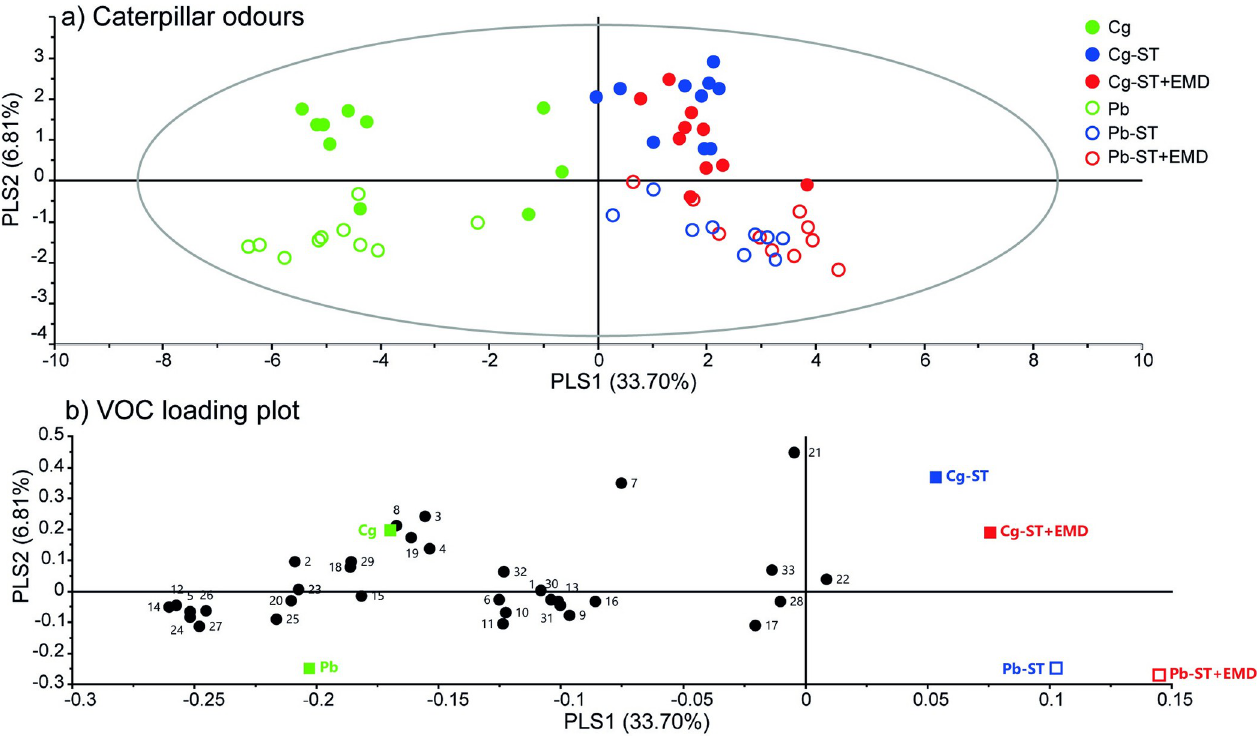
Fig 3. Overview of caterpillar volatile profiles of untreated, starved or starved then external microbiome disrupted C . glomerata parasitised or unparasitised caterpillars ( P . brassicae ). a) OPLS-DA (Orthogonal Projection to Latent Structures Discriminant Analysis) plot for the volatile blends of different groups of caterpillars. The Hotelling’s T2 ellipse confines the confidence region (95%) of the score plot. b) Loading plot defining the contribution of each of the volatile compounds to the separation of treatment groups. Volatile compounds closer to a treatment in the plot correlate stronger with the treatment. For compound identity see Table 1. Abbreviations used: Cg = Untreated parasitised caterpillars; Cg-ST = starved parasitised caterpillar; Cg-ST +EMD = starved then external microbiome disrupted parasitised caterpillars. Pb = Untreated unparasitised caterpillars; Pb-ST = starved unparasitised caterpillars; Pb-ST+EMD = starved then external microbiome disrupted unparasitised caterpillars.